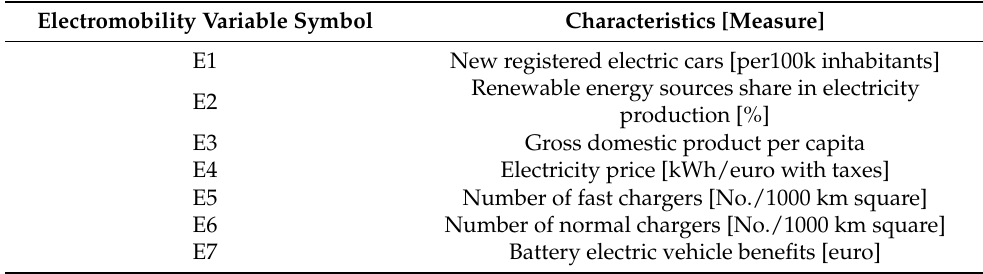
Table 8. Electromobility variables in the EU in